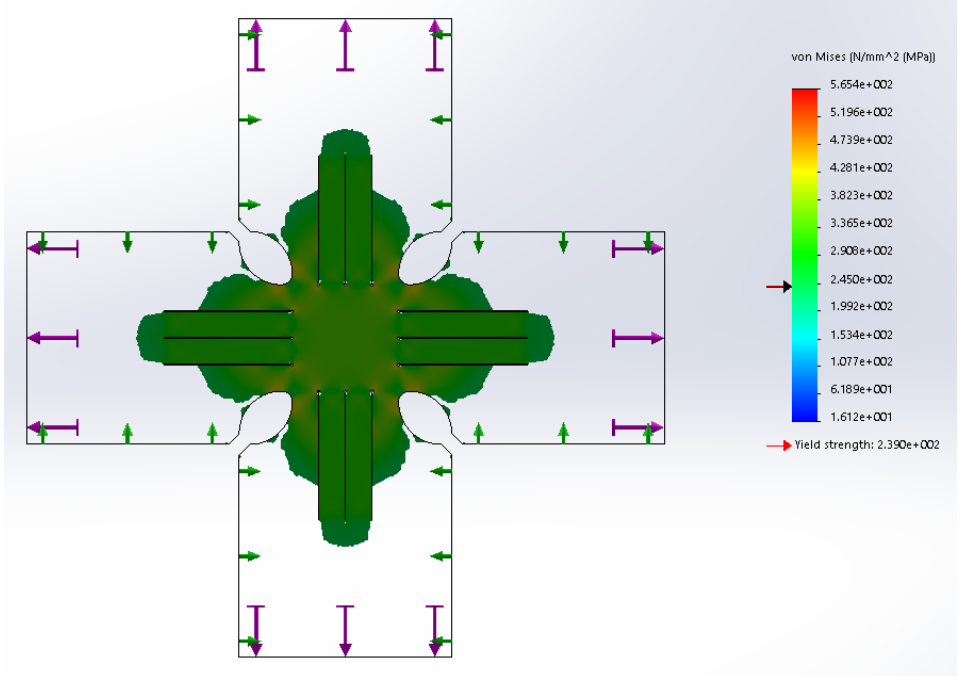
Figure 27. Applying the iso clipping function to isolate values of stress which are more than the yield strength in the plastic region. Purple arrows show the direction of the load; green arrows show the virtual action of the slider.